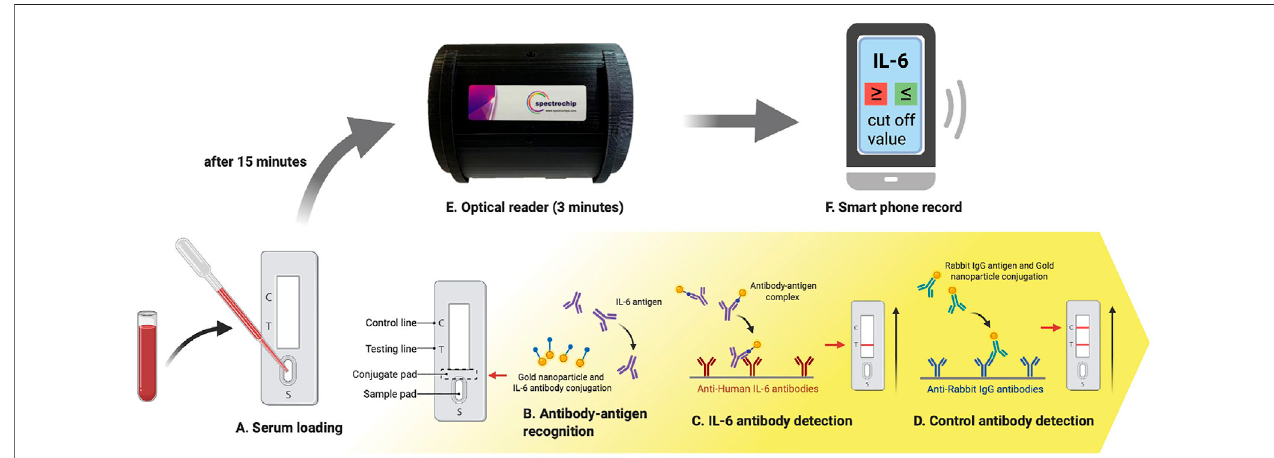
FIGURE 4 | The IL-6 test strip work fl ow coupled with a spectrum-based optical reader. This new spectrum analyzer platform system requires only 0.1 ml of blood serum to be added to the test strip, and provides results in 15 min. The test strip is placed in a spectrometer for quantitative spectral analysis. This scan takes approximately 3 min to complete. Automatic scanning of the rapid test strip is activated with an APP. Full-spectrum antibody re fl ex optical signals are acquired from the spectral optical module to analyze IL-6 full-spectrum antibody distribution and concentration with standard quanti fi cation.